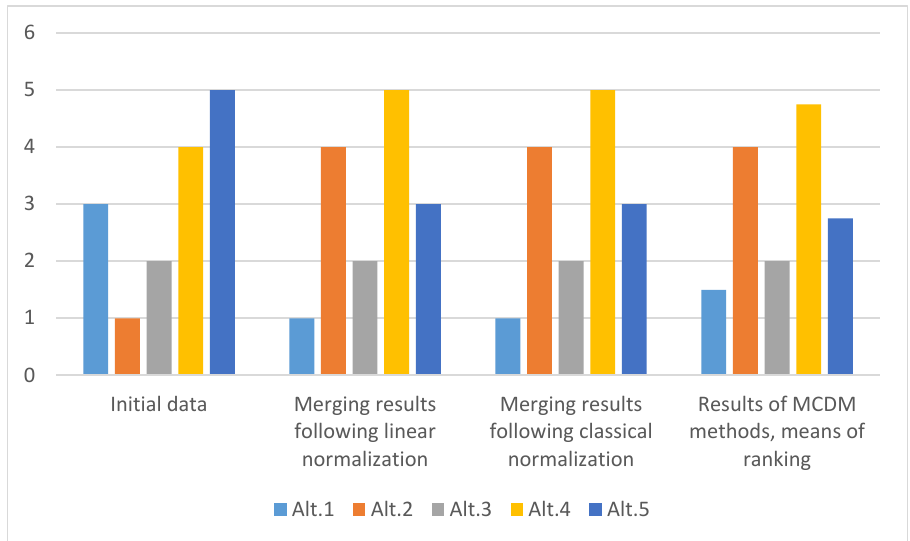
Figure 8. The results of evaluating alternatives, means of the ranked values.